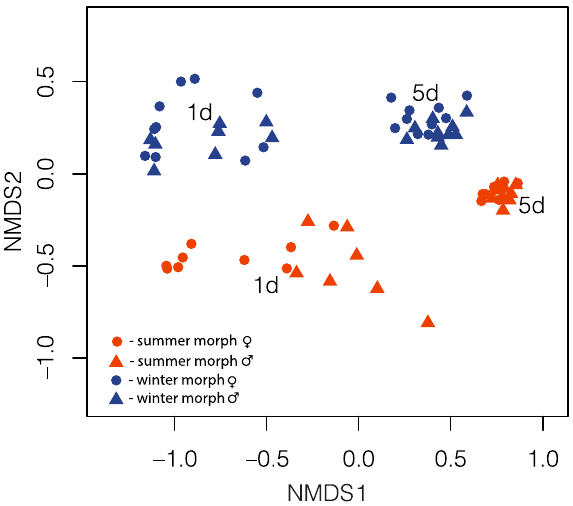
Figure 2. Nonmetric multidimensional scaling (NMDS) based on Bray–Curtis distance between samples. Data is displayed in a two-dimensional graph (stress = 0.053).1d: 1-day-old, 5d: 5-day-old.